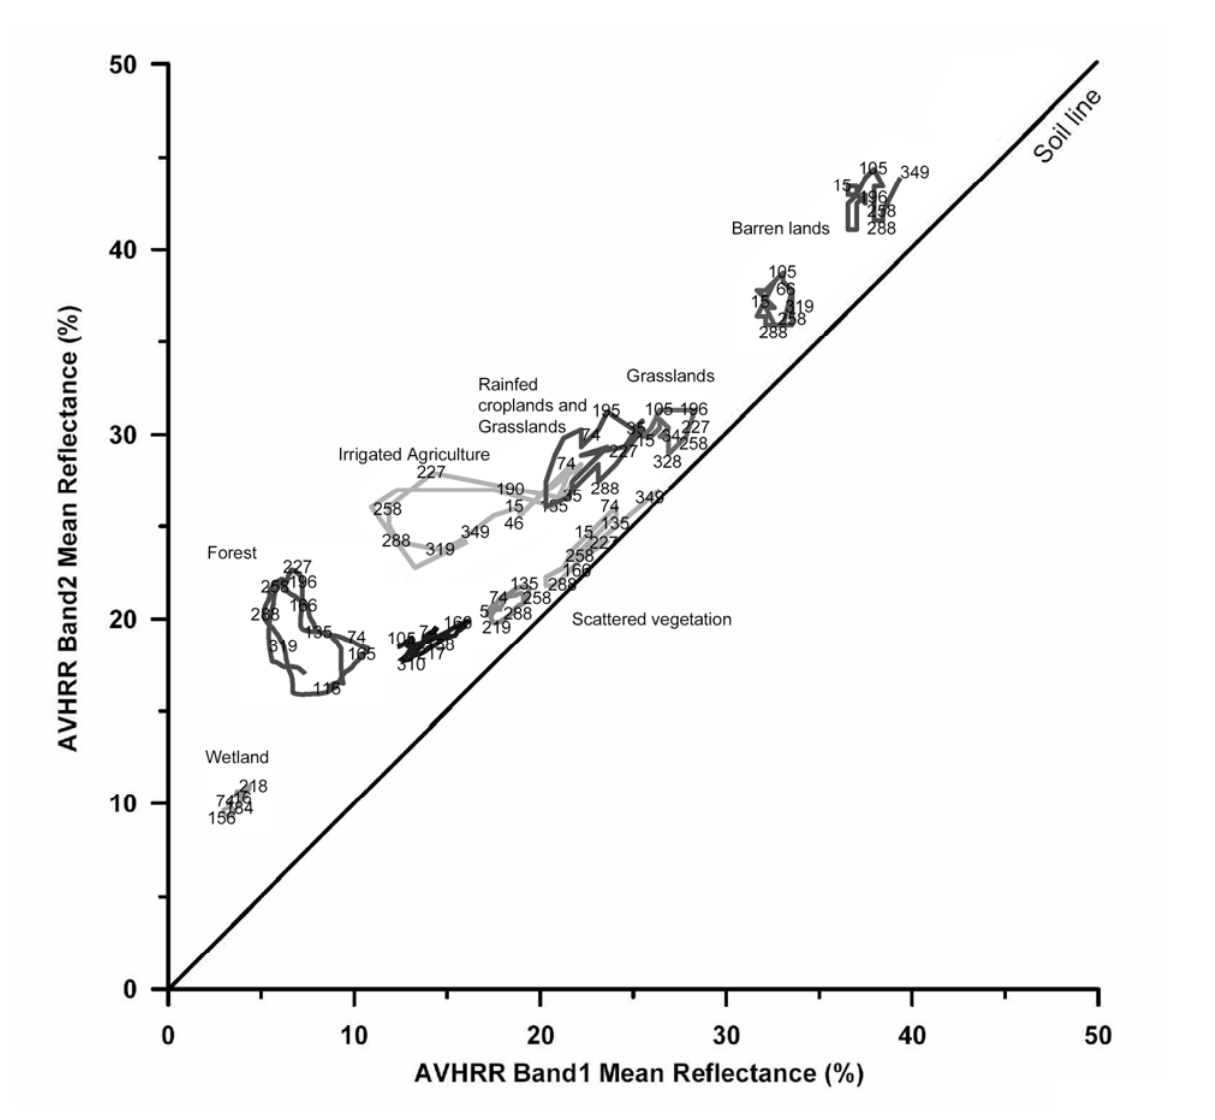
Figure 4. Space-time spiral curves (ST-SCs) in class identification and labeling. The ST-SCs track changes of time series over time and across space. The numbers seen in each class represent Julian date and each class moves around a ‘territory’ in 2D feature space over time. Adapted from Thenkabail et al.